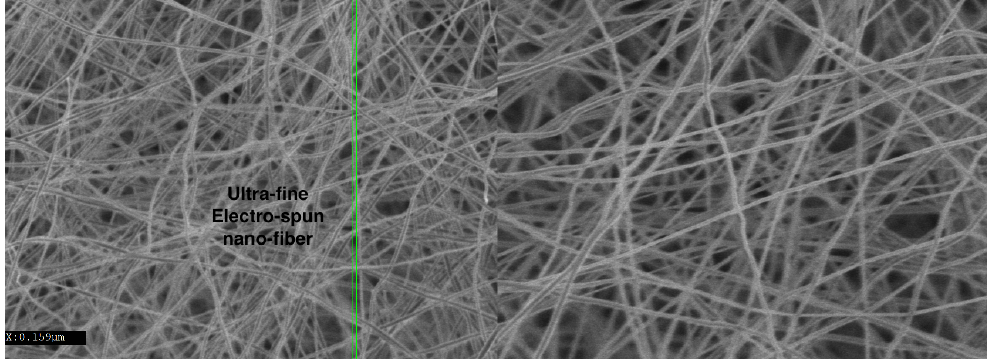
Figure 15. An example of uniform ultra-fine nano-fibers (diameter < ∼ 150 nm) resulting from polymerized electro-spun V 2 O 5 / GO tailored for Li-ion cathode materials suitable for the fabrication of ultra-high capacity Li-ion batteries. Reprinted from ref.